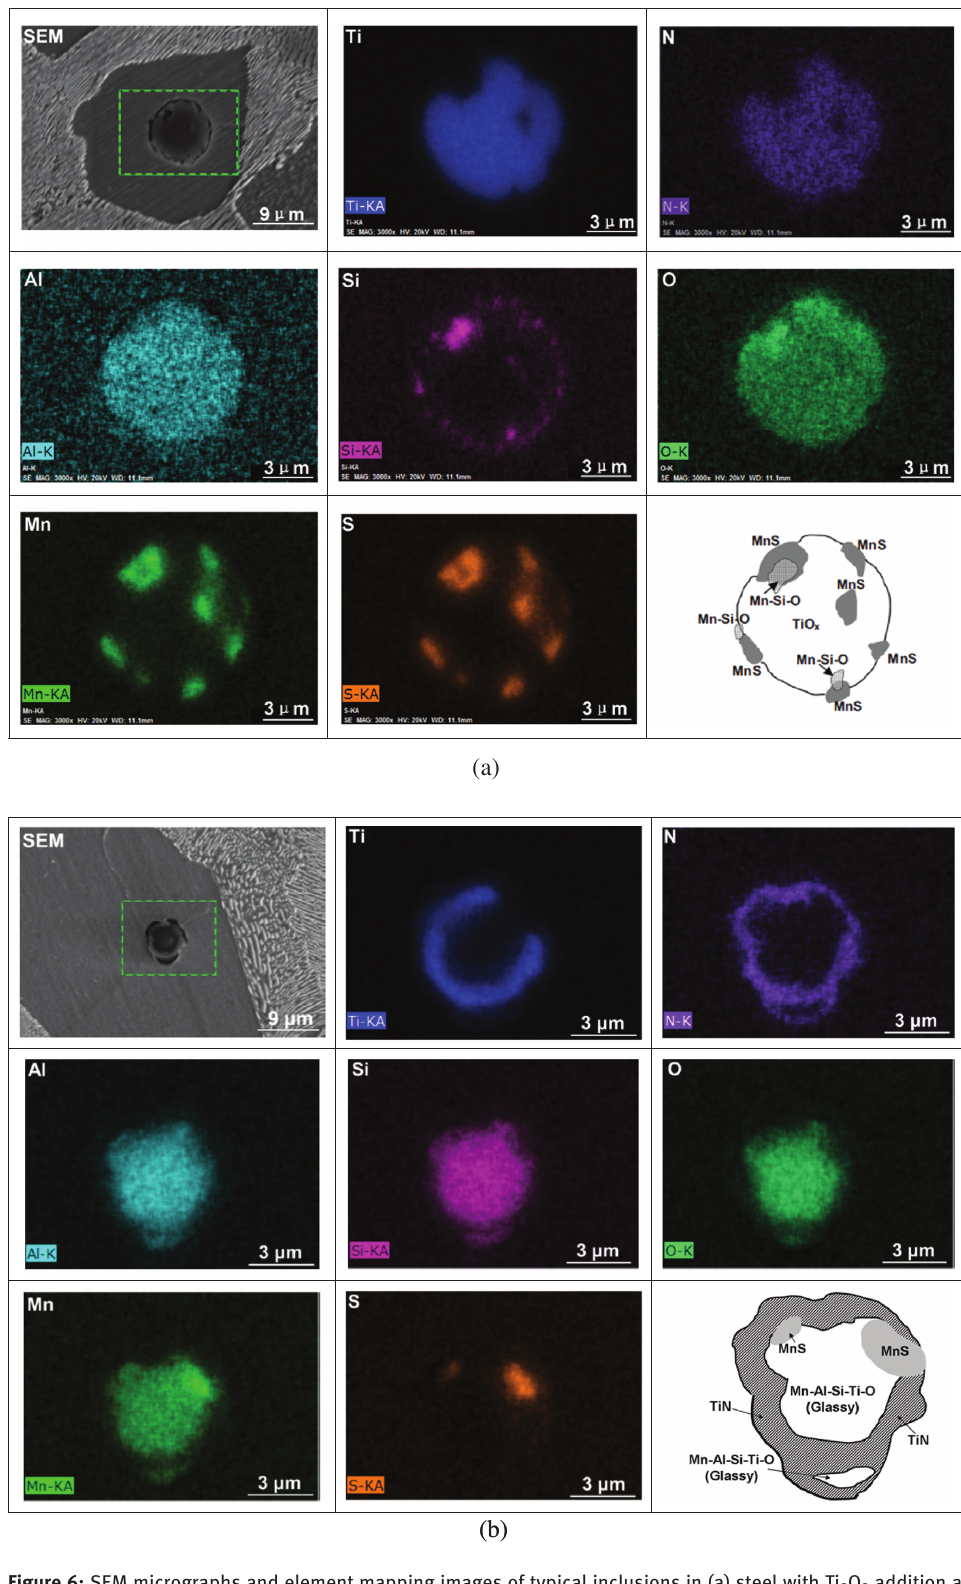
Figure 6: SEM micrographs and element mapping images of typical inclusions in (a) steel with Ti 2 O 3 addition and (b) steel with TiN addition [8 –